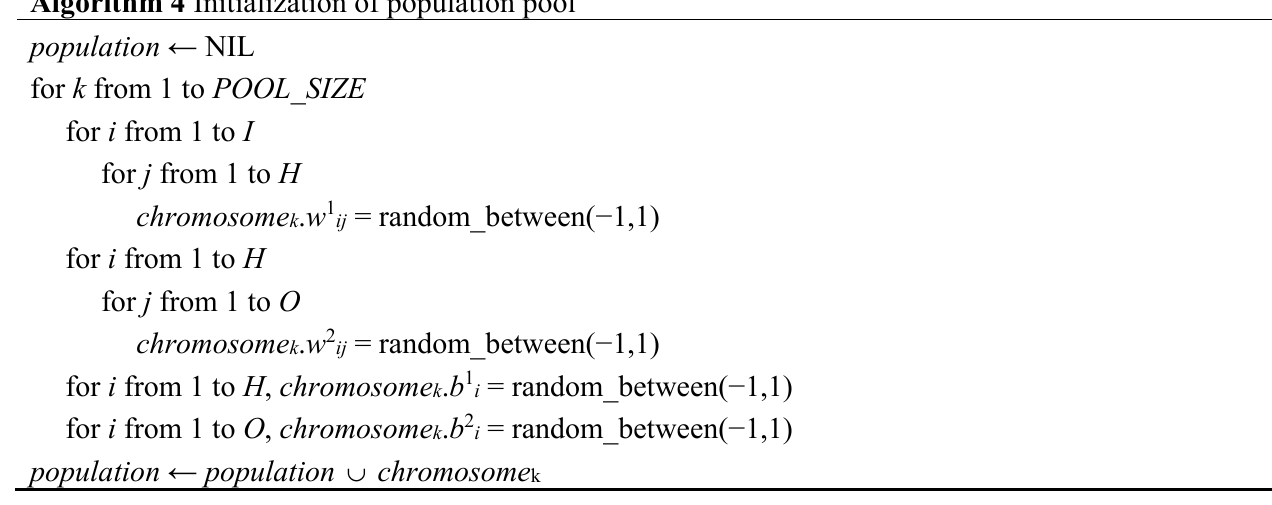
Algorithm 4 Initialization of population